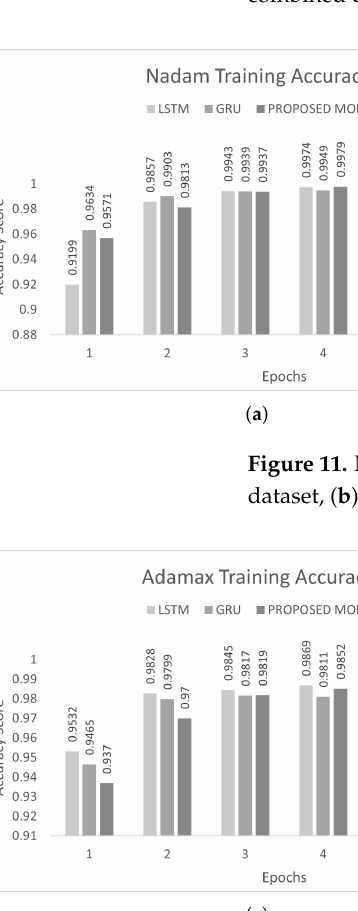
Figure 10. Adam training on the combined DDoS dataset. ( a ) Adam training accuracy on the combined dataset, ( b ) Adam training loss on the combined dataset.